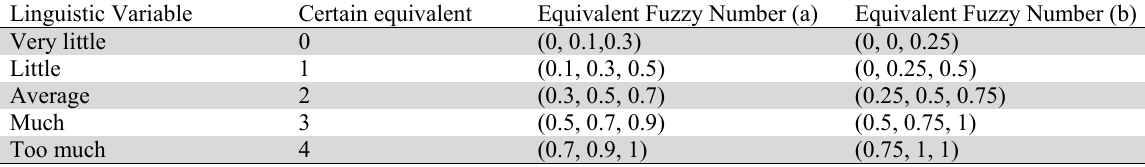
Linguistic variables and equivalent fuzzy numbers (Zhu et al., 2012) Linguistic